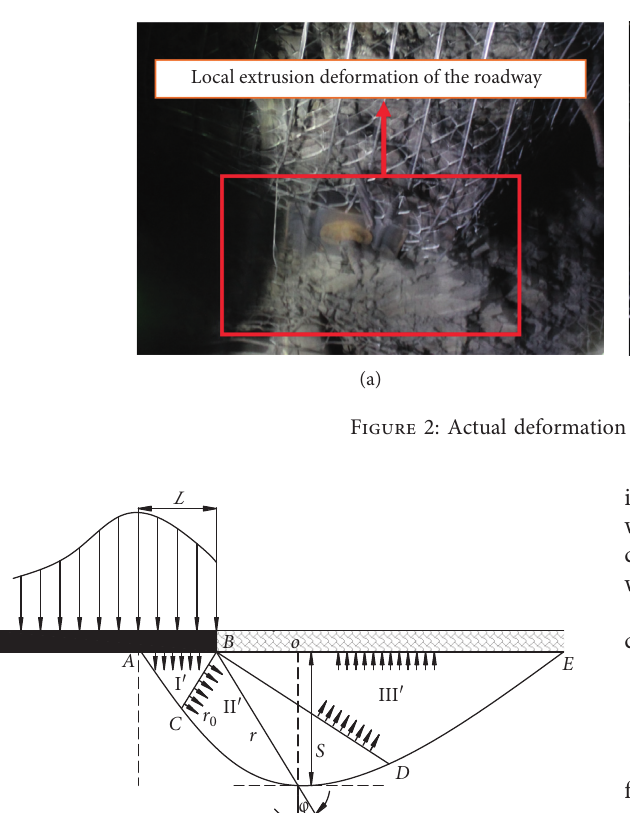
Figure 3: Mechanical model of floor failure caused by abutment